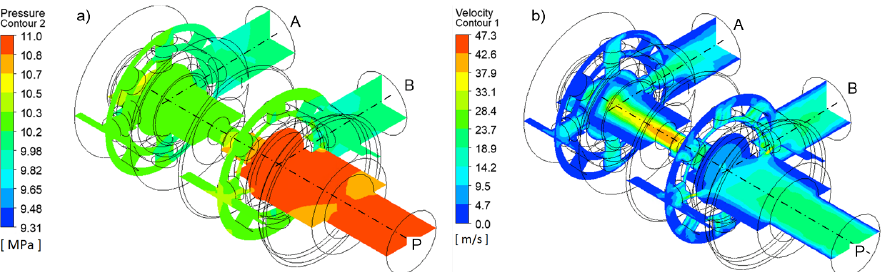
Figure 7. CFD results for equal loads on both outputs in the isometric view: ( a ) pressure distribution, ( b ) velocity distribution; P, A, B—connection ports.